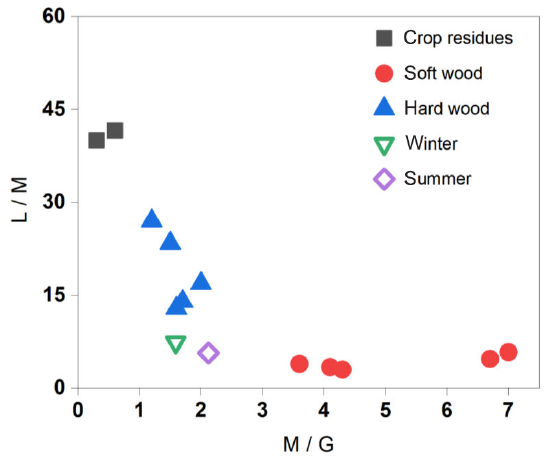
Figure 8. Scatter plot of the L / M and M / G ratios of samples dur- ing winter- and summertime in this study as well as ratios from dif- ferent sources, including crop residues, softwood, and hardwood, in existing literature (Sheesley et al., 2003; Fine et al., 2004; Oros et al., 2006; Engling et al., 2006).